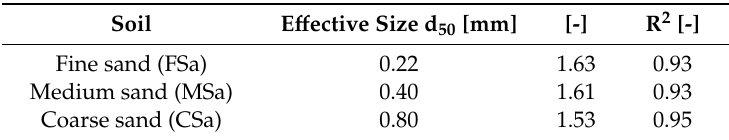
Table 1. Empirical constants in the relationship between the degree of saturation and electrical resistivity according to Equation (4) [45].